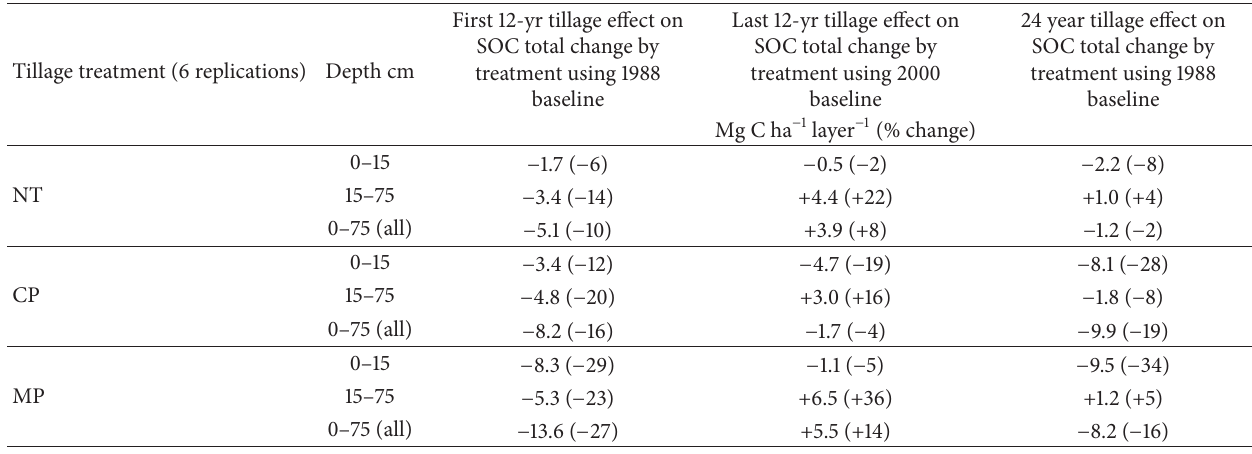
Table 7: Use of pretillage treatment (1988) SOC values (sod) as baseline to determine the total SOC change in the first 12 years and during 24 years of tillage treatments. The 2000 SOC values for each plot were used as baseline to determine the total SOC content change during the last 12 years for the Grantsburg soil.